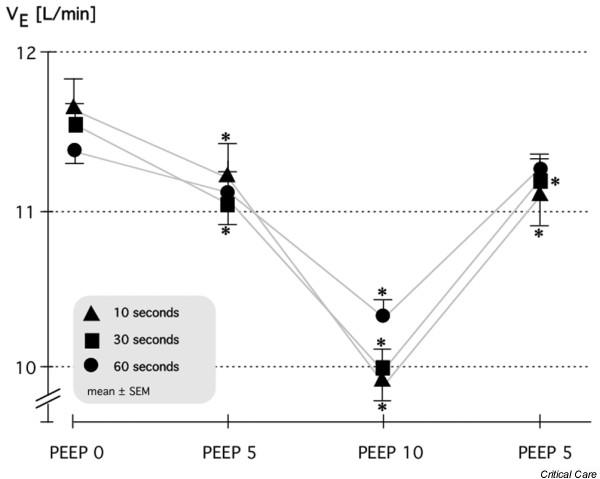
Effects on breathing pattern brought on by steps in PEEP of different duration. Effects are shown on VE, which behaved similarly whether the PEEP steps were applied for 10, 30, or 60 s. *P < 0.025, versus zero PEEP. PEEP, positive end-expiratory pressure; VE, minute ventilation.